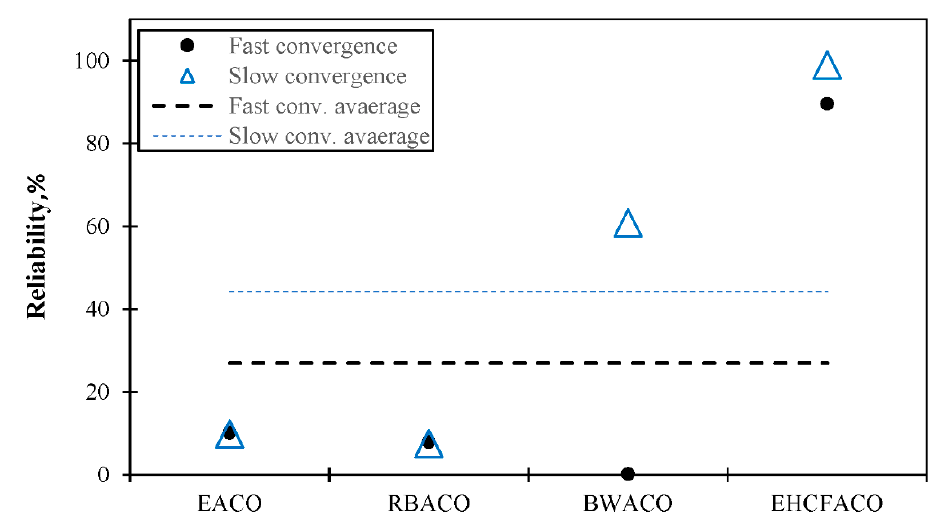
Figure 6. Reliability of EACO, RBACO, BWACO, and EHCFACO algorithms.